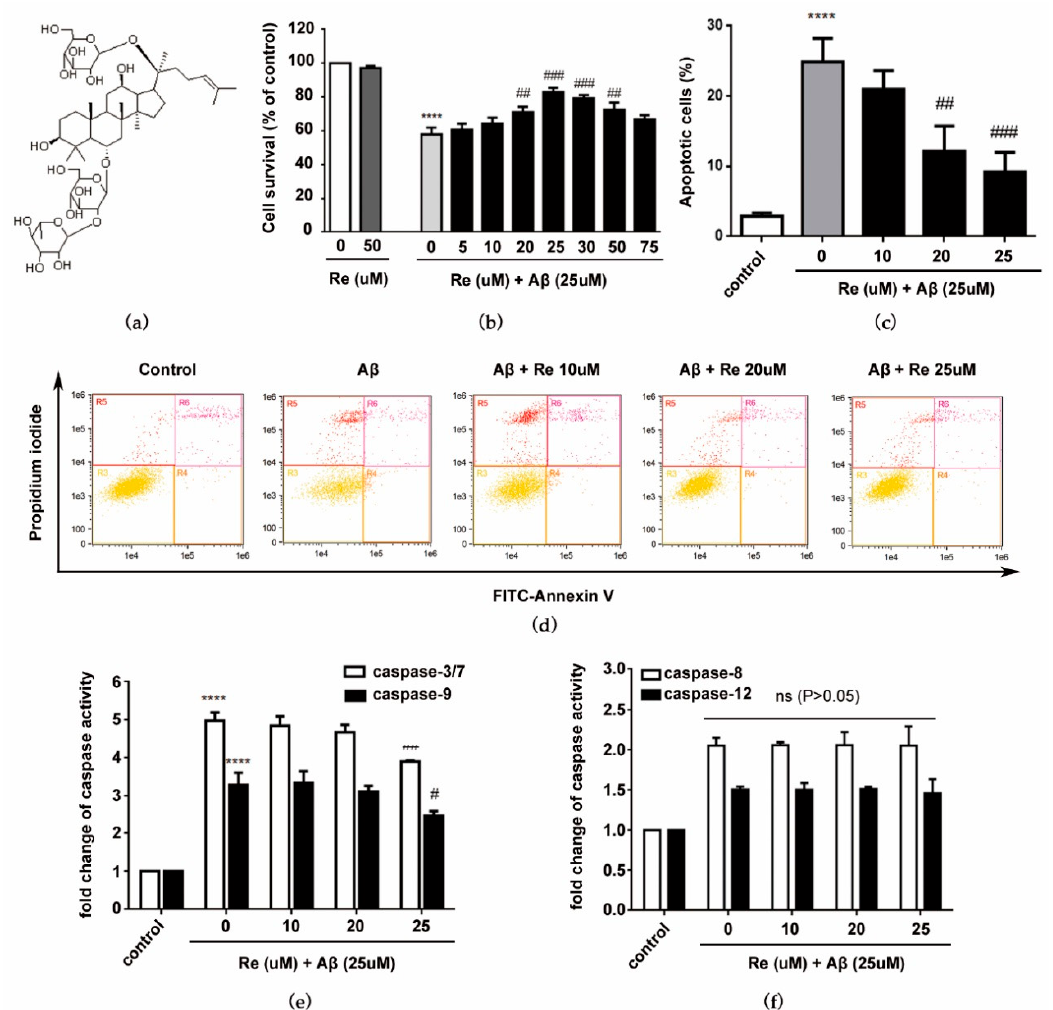
Figure 1. Protective effects of ginsenoside Re against A β 25–35-induced cell damage. ( a ) Chemical structure of ginsenoside Re (molecular formula: C48H82O18; molecular weight: 947.12); ( b ) SH-SY5Y cells were co-treated with ginsenoside Re and A β for 24 h. Cell viability was determined by CCK-8 assays. Bar diagrams showing percentage of survival cells; ( c ) bar diagrams showing percentage of apoptosis; ( d ) annexin V / FITC-PI staining and flow cytometric analysis of apoptosis; ( e ) caspase-3 / 7 and caspase-9 activity were assessed by fluorometric and colorimetric assay, respectively; and ( f ) caspase-8 and caspase-12 activity were assessed by fluorometric assay. **** p < 0.0001 versus control; # p < 0.05, ## p < 0.01, ### p < 0.001 versus A β treatment.